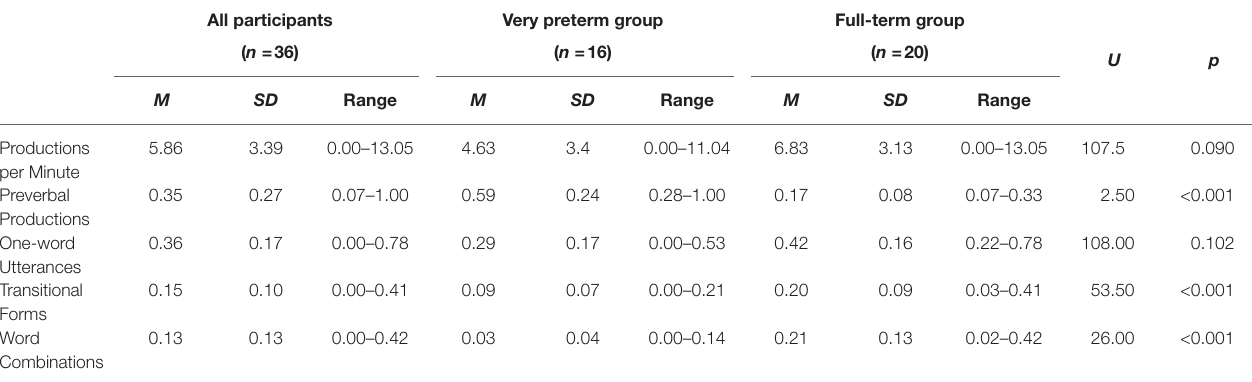
TABLE 2 | Descriptive data for children’s speech measures and Mann-Whitney tests comparing mothers of very preterm and full-term children. All